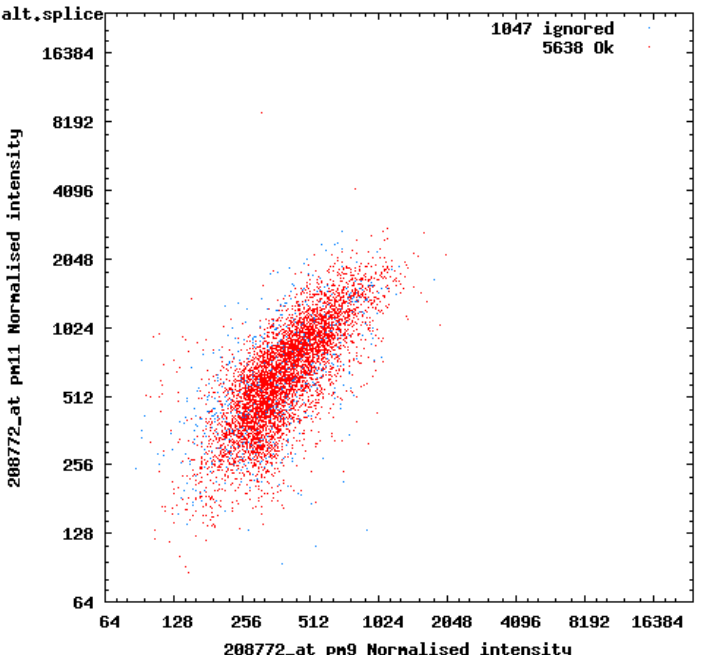
Figure 6: A scatter plot of the log2 intensities between perfect match probes 9 and probe 11 from probeset 208772 at, obtained from 5638 HG-U133A GeneChips. For this particular probe pair, 1047 of the original set of 6685 chips were flagged as possibly providing spurious signals or being close to dubious